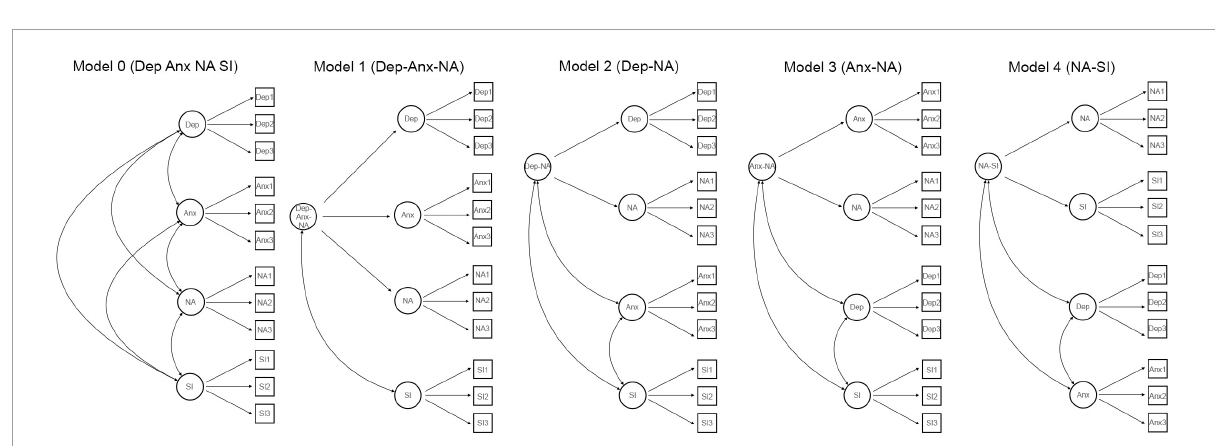
FIGURE2 Confirmatory factor analysis models of the relationship between depression, anxiety, negative affectivity, and social inhibition. Circles represent latent variables and squares represent observed variables. Anx, Anxiety; Dep, Depression; NA, Negative Affectivity; SI, Social Inhibition.